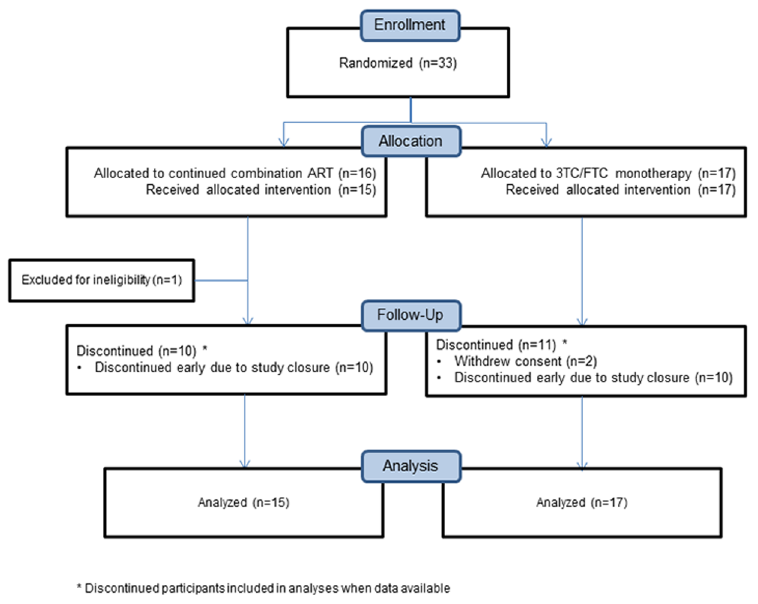
Fig 1. CONSORT diagram for